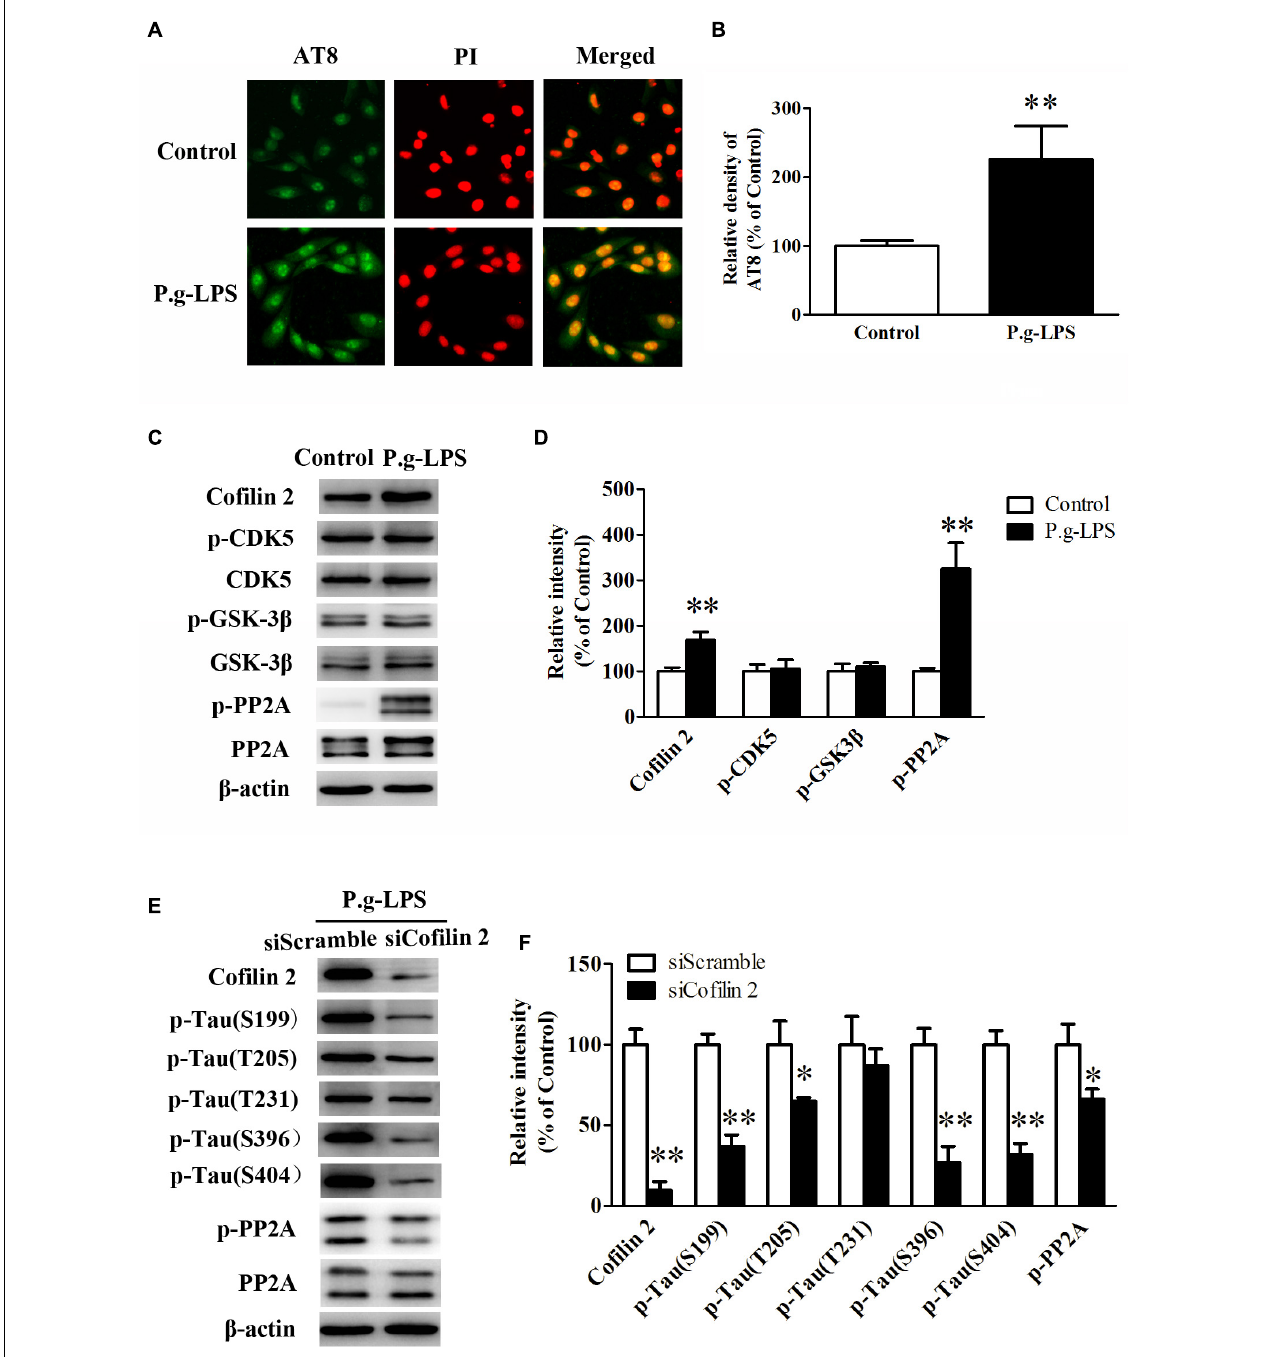
FIGURE 4 | Cofilin 2 facilitated the hyperphosphorylation of tau through PP2A. (A) Immunofluorescence staining of AT8 in control and P.g-LPS treated SK-N-SH APPwt cells. (B) Quantitative comparison of the immunofluorescence staining of AT8 in control and P.g-LPS treated SK-N-SH APPwt cells. (C) Representative panel of the Western blot of Cofilin 2, p-CDK5, CDK5, p-GSK-3 β , GSK-3 β , p-PP2A, and PP2A in control and P.g-LPS treated SK-N-SH APPwt cells. (D) Quantitative comparison of the Western blot of Cofilin 2, p-CDK5, CDK5, p-GSK-3 β , GSK-3 β , p-PP2A, and PP2A in control and P.g-LPS treated SK-N-SH APPwt cells. (E) Representative panel of the Western blot of Cofilin 2, tau phosphorylation at Ser199, Thr205, Thr231, Ser396, and Ser404, p-PP2A, and PP2A in siScramble group and siCofilin 2 group. (F) Quantitative comparison of the Western blot of Cofilin 2, tau phosphorylation at Ser199, Thr205, Thr231, Ser396, and Ser404, p-PP2A, and PP2A in siScramble group and siCofilin 2 group. Data represent mean ± SD. ∗ p < 0.05 vs. control group, ∗∗ p < 0.01 vs. control group.